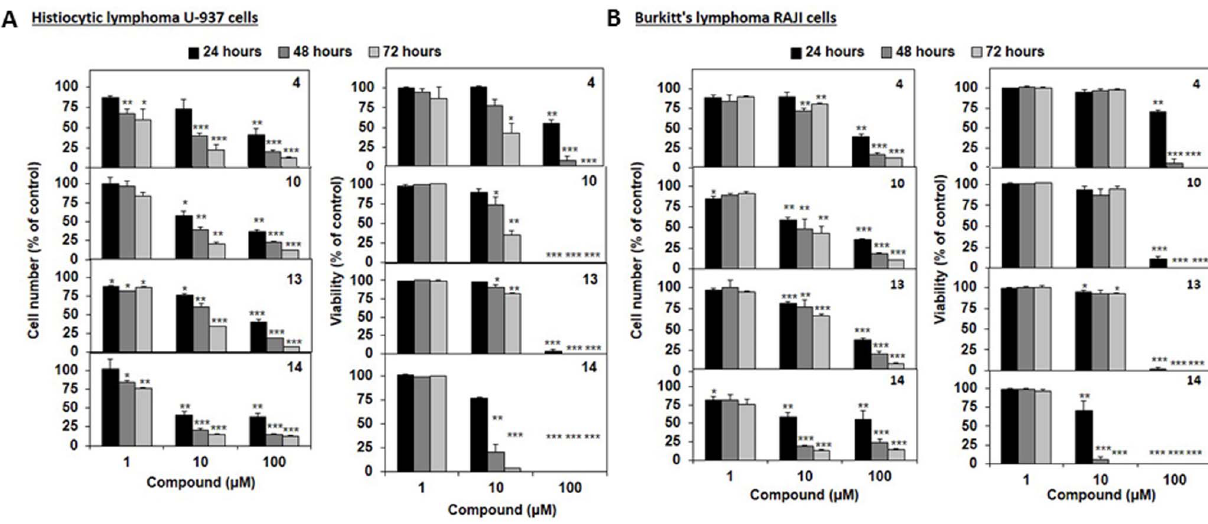
Figure 5. Effects of selected compounds in human lymphoma U-937 and RAJI cells. Cells were treated with the indicated concentration of compounds 4 , 10 , 13 and 14 for up to 72 h. Antiproliferative effects (left) and cell death induction (right) on (A) U-937 and (B) RAJI lymphoma cell lines. Results are the mean 6 SD of at least three independent experiments. *, **, *** indicate p , 0.05, p , 0.01, p , 0.005 versus untreated cells, respectively.